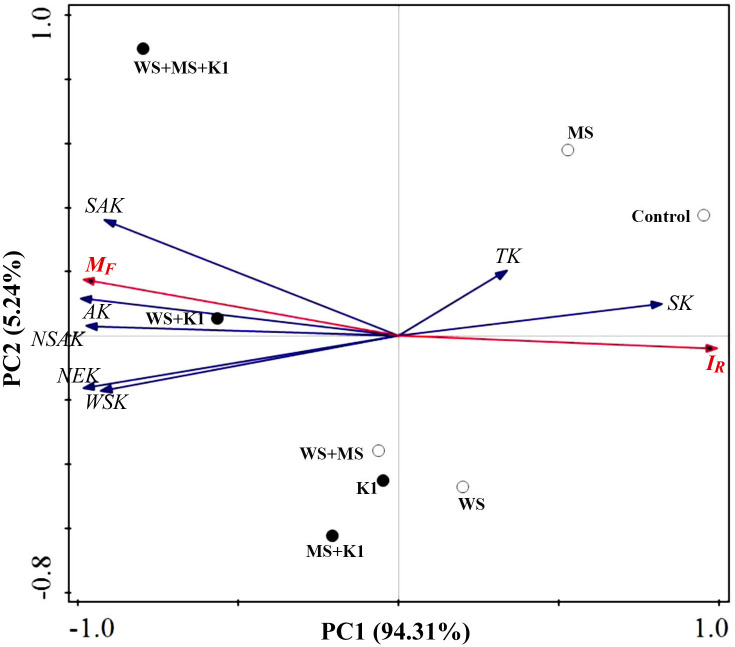
Score scaling for principal components analysis, in which the indexes of soil K are represented by vectors and treatments are represented by symbols.AK, available K; WSK, water-soluble K; NSAK, non-specific adsorptive K; SAK, specific adsorptive K; NEK, non-exchangeable K; SK, structural K; TK, total K. MF and IR represent the mobility factor and the reduced partition index for soil K, respectively. Control, no K addition; WS, wheat straw addition at 12 g straw·kg-1 dry soil; MS, maize straw addition at 12 g straw·kg-1 dry soil; WS+MS, wheat and maize straw addition, both at 12 g straw·kg-1 dry soil; K1, K fertilization at 200 mg K2O·kg-1 dry soil.